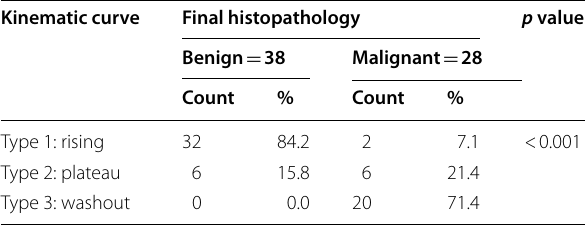
Table 5 Performance of CE-MRI kinematic curves and